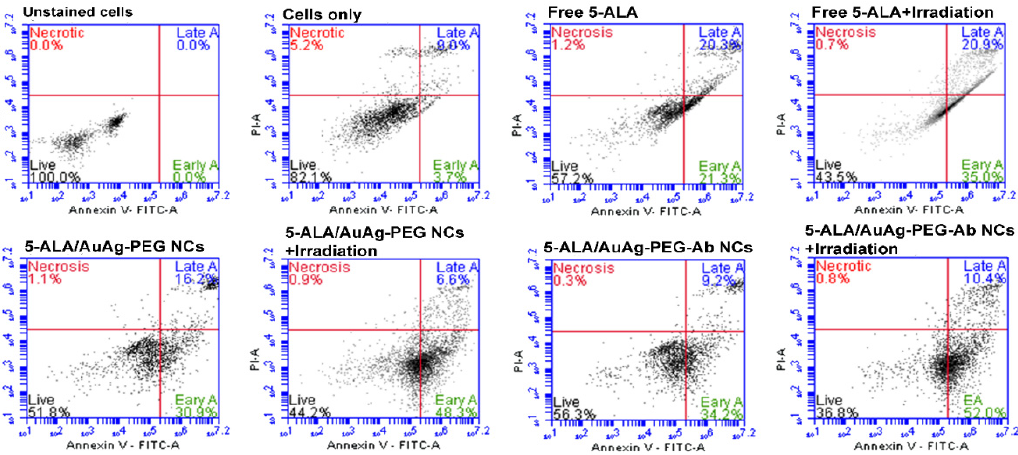
Figure 5. Flow cytometry analysis using the Annexin V-FITC/PI staining method on PDT-treated MCF-7 cells with Free 5-ALA, 5-ALA-Au–Ag-PEG, and 5-ALA-Au–Ag-PEG-Ab NCs under an equivalent concentration of 5-ALA.